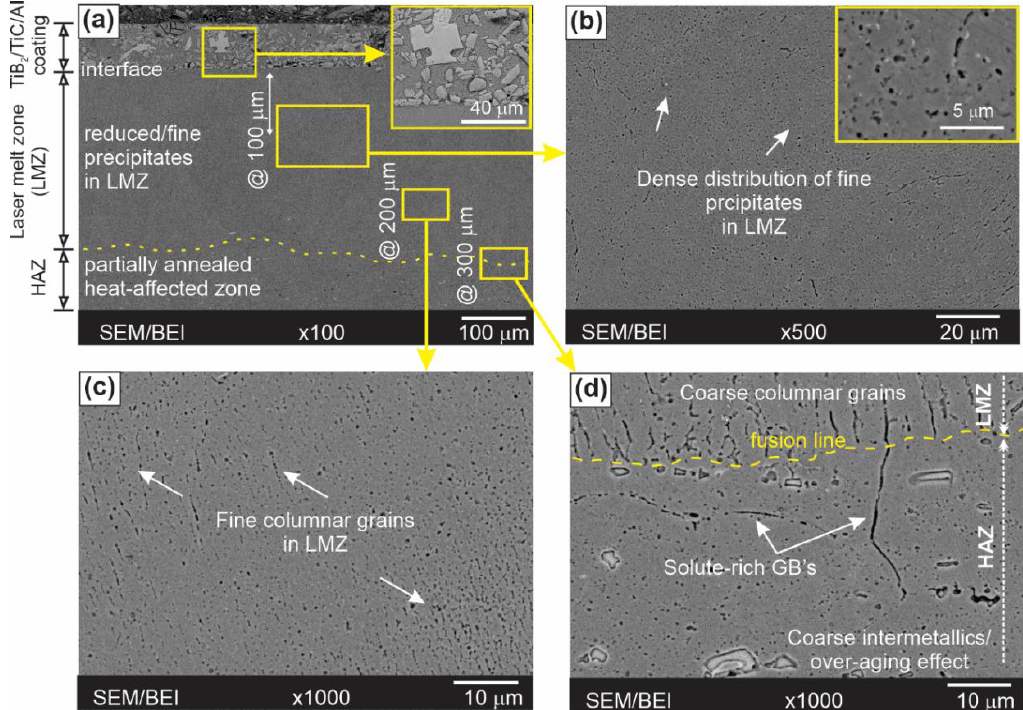
Figure 3. Cross-section SEM / BEI micrographs of the LSA TiC / TiB 2 / Al composite coating processed with LED of 20 J / mm 2 ; ( a ) larger region at lower magnification, ( b – d ) magnified images corresponding to the specific region below the interface, marked on ( a ).